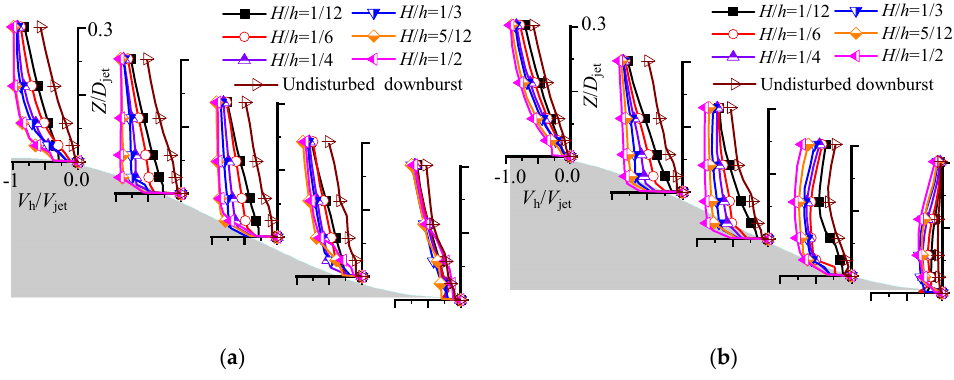
Figure 22. Profiles of vertical wind velocity ( r h = 0.0 D jet ): ( a ) L = 0.5 D jet ; ( b ) L = 1.0 D jet .